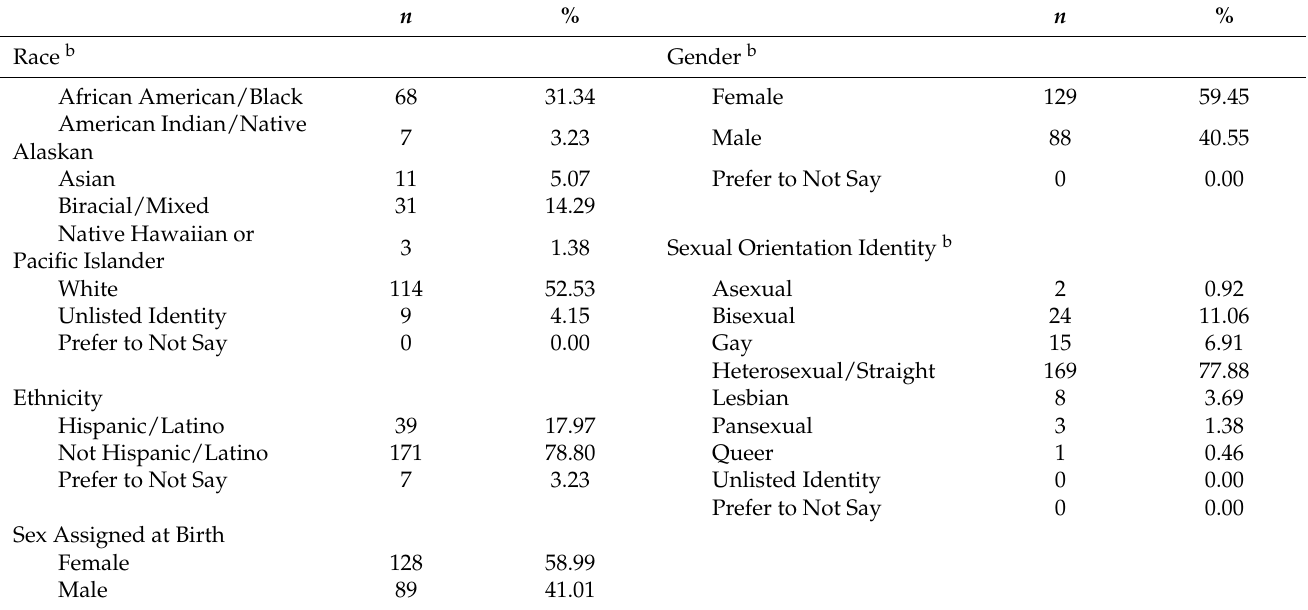
Table 1. Demographics of Study Participants a